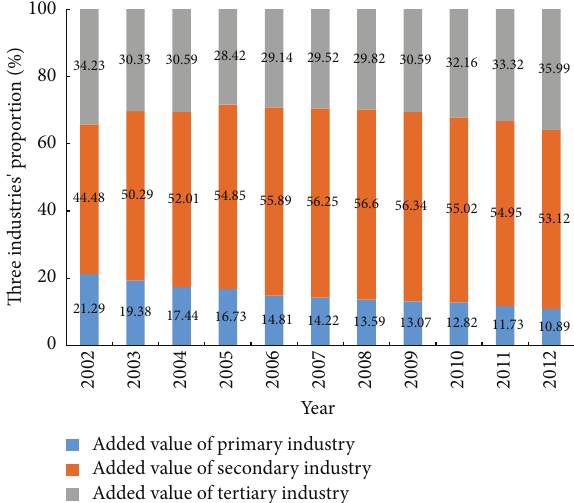
Figure 3: Three industries’ structure in the Nansi Lake Basin during 2002 ∼ 2012.